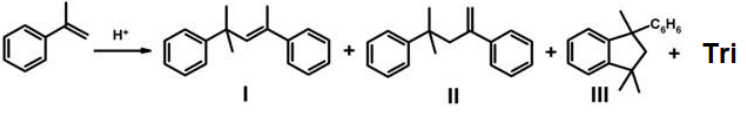
Figure 13. Reaction oligomerization of α -methylstyrene.